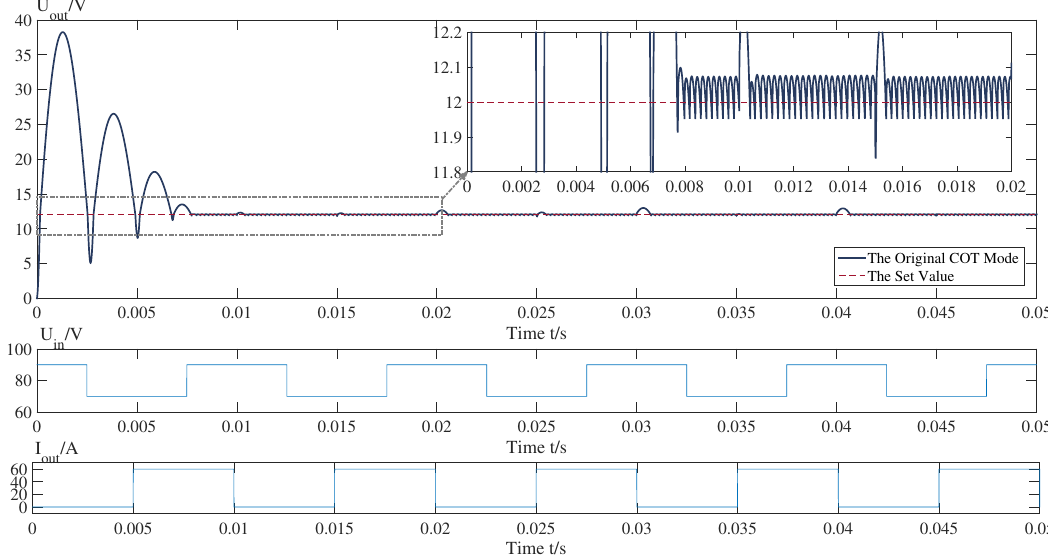
Figure 3. The output voltage of the Buck circuit with COT voltage